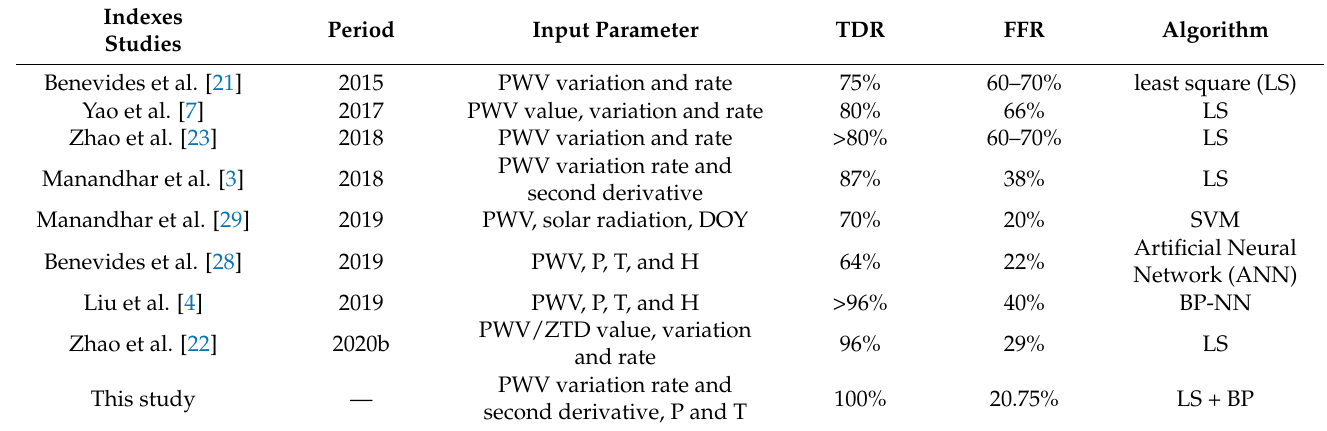
Table 5. Precision of existing rainfall early warning